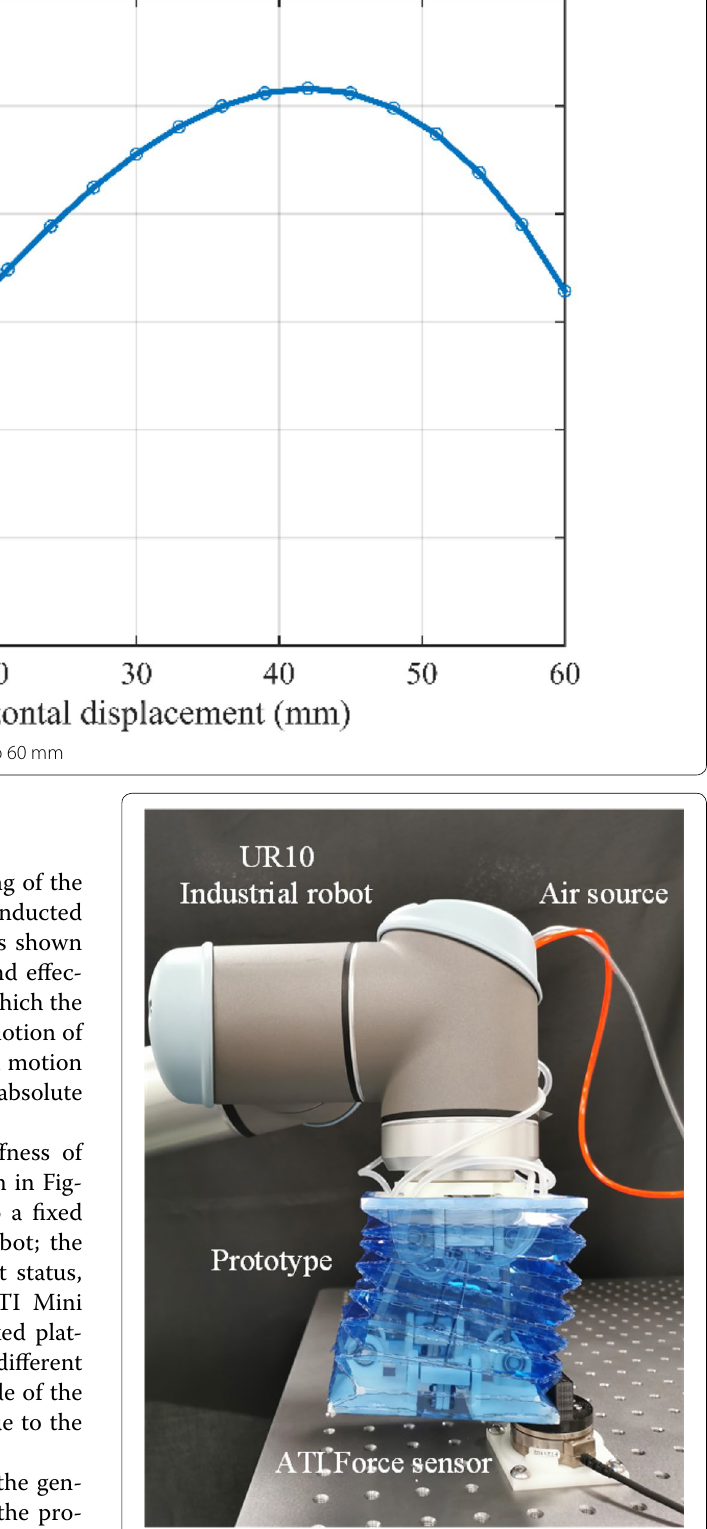
Figure 9 Setup of the stiffness